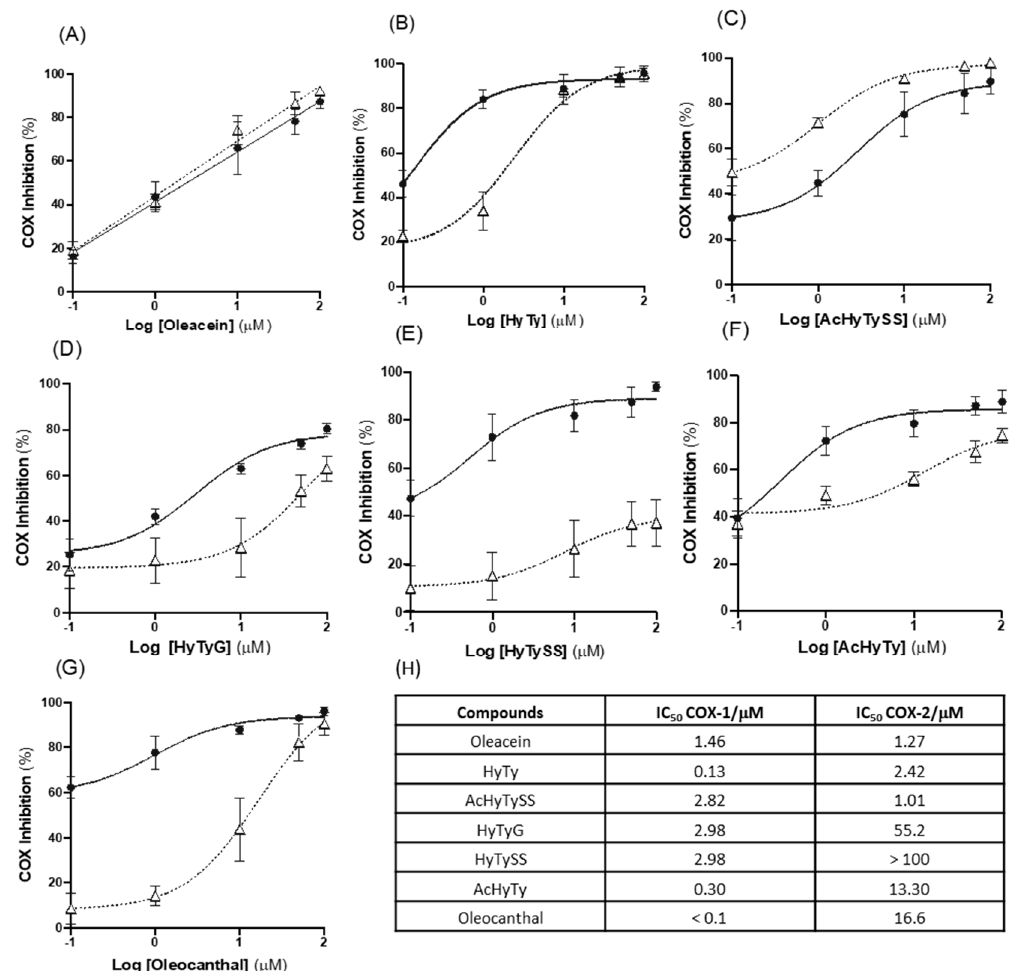
Figure 6. Inhibitory activity of oleacein ( A ), HyTy ( B ), AcHyTySS ( C ), HyTyG ( D ), HyTySS ( E ), AcHyTy ( F ) and Oleocanthal ( G ) on COX-1 (solid lines) and COX-2 (dotted lines) enzymes. Results are expressed as the mean ± SEM of three independent assays, each performed in duplicate. IC 50 values (µM) of COX-1 and COX-2 enzymes for studied compounds ( H ). SC-560 was used as the positive control for COX-1 and Dup-697 was used as the positive control for the COX-2 inhibition test.